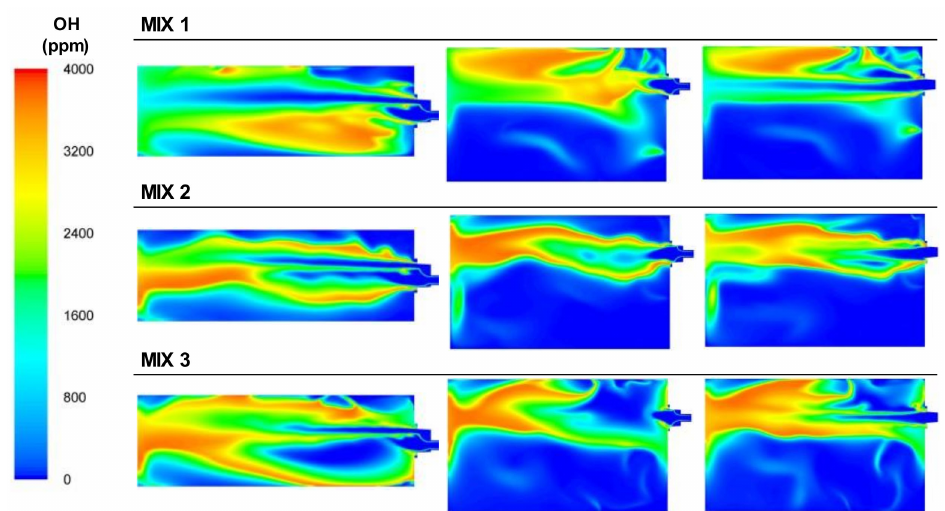
Figure 19. Contour plots of OH concentrations for the BFG/NG mixture cases in the XZ1, XY1, and XY2 planes.